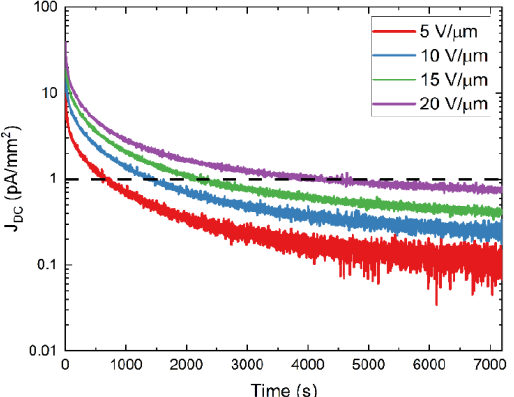
Figure 5. Experimental DC kinetics data plotted in a semi-log scale corresponding to a PI/a-PbO detector biased at selected fields (5–20 V/ µ m) for two hours. The horizontal dashed line illustrates the operational threshold of 1 pA/mm 2 . Data extracted from [5].